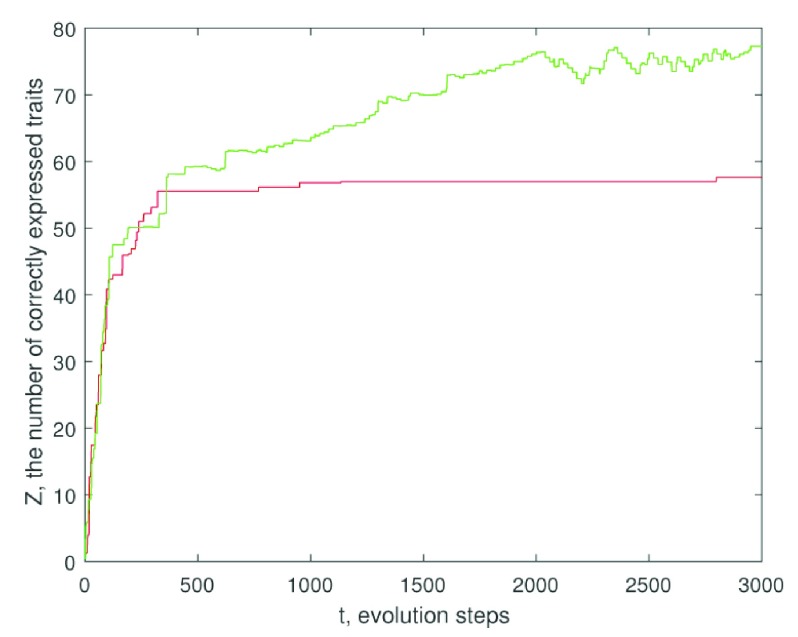
This graph illustrates a difference between the adaptation for evolution without evolution of gene regulation via threshold (the red curve) and with that evolution by 2.12 (the green curve).The parameters are
N
g = 50,
M = 300, the mutation rate
p
mut = 0.01,
γ = 1 and
K = 4. Non-zero coefficients
w
ij are random numbers distributed according to the standard normal law. The initial genome is a random binary string, where each value is 0 or 1 with probability 1/2. The coefficients
b
i are either 1 or −1, where the probability of 1 is
p
b = 0.8.